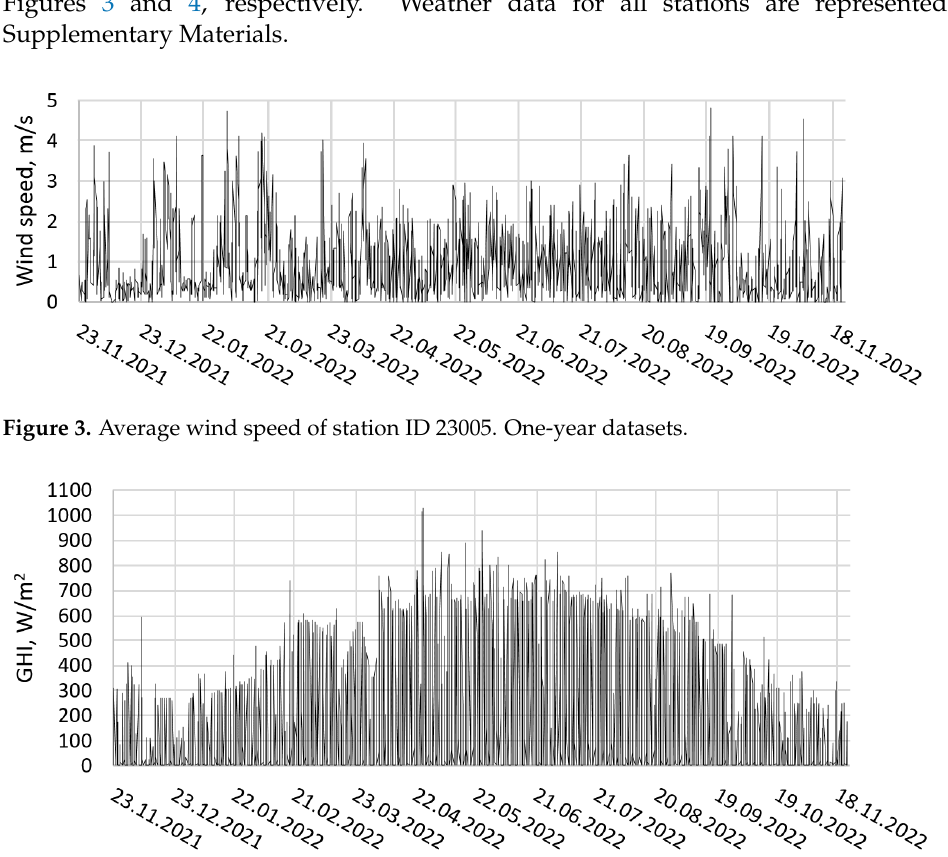
Figure 4. GHI of station ID 23005. One ‐ year datasets.